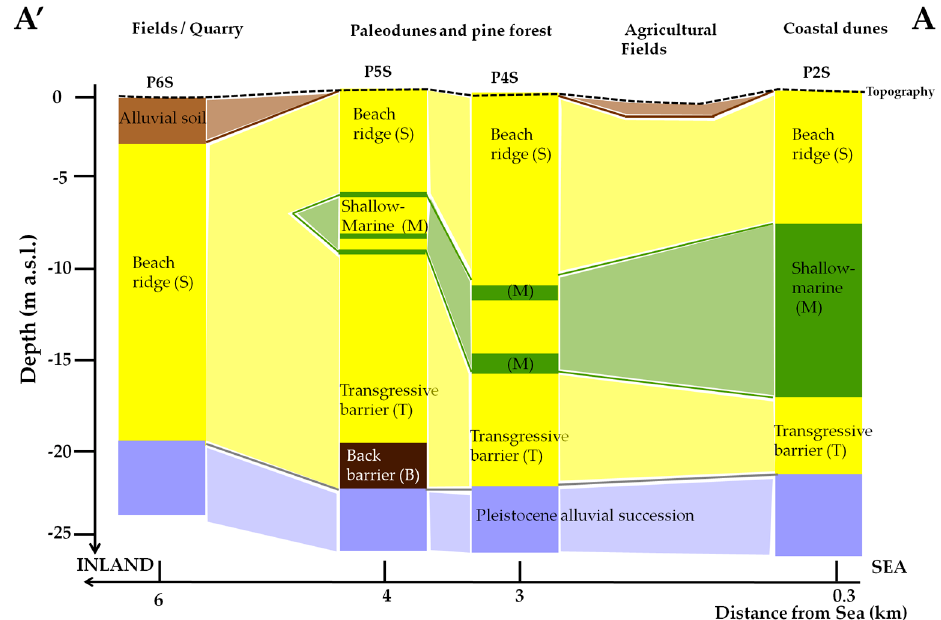
Figure 2. Geological section of the shallow coastal aquifer. Refer to Figure 1 for the section location. Depositional environments and interpolations are based on Amorosi et al. [50]. With respect to coastal dunes and paleodunes, the aquifer is phreatic, while it is semi-confined in agricultural fields and quarry